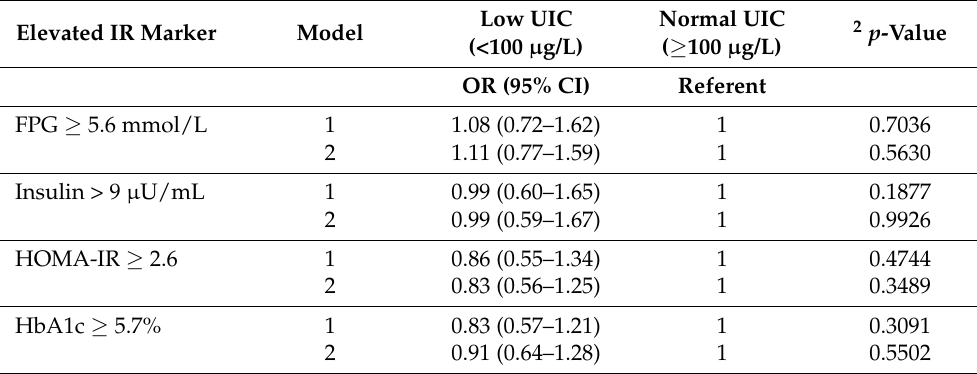
Table 4. Prevalence of elevated markers insulin resistance in relation to urinary iodine concentration in US adults, NHANES 2011–2012 1 . Elevated IR Marker